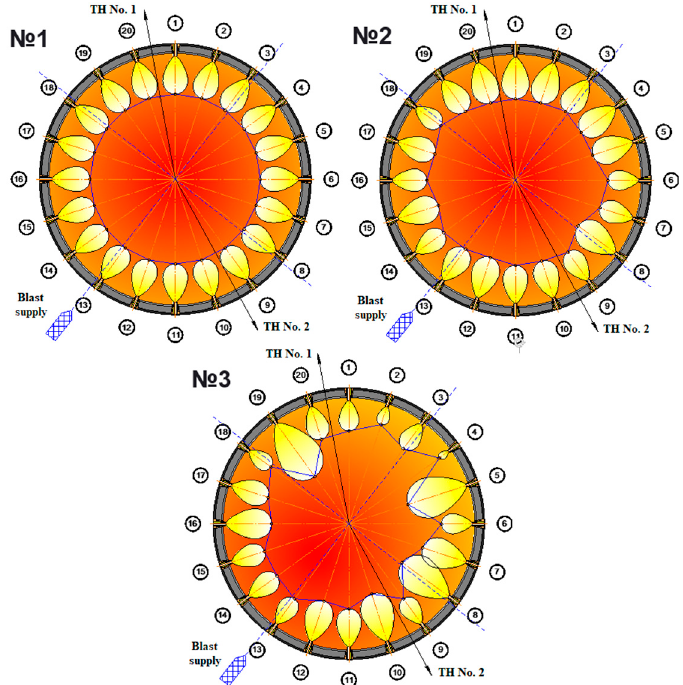
Figure 3. Tuyere hearths for three variants of blast distribution at BF No. 1M, PrJSC “Kamet-steel”: 1, . . . , 20 air tuyeres; TH No. 1, No. 2 (cast-iron tapholes).